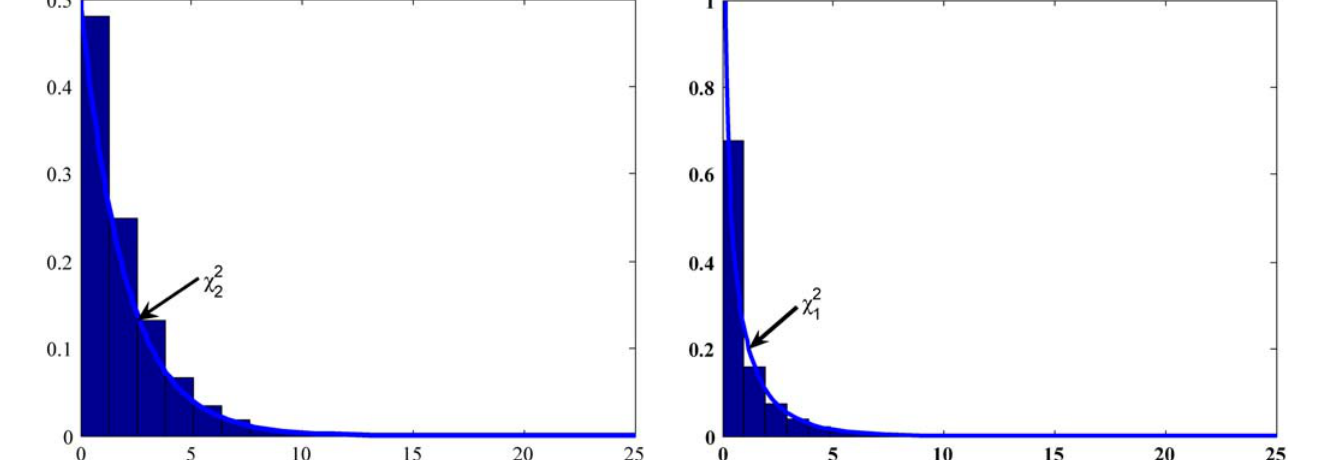
Figure 1. Null Distribution of the statistic T GE for 400 cases and controls respectively.